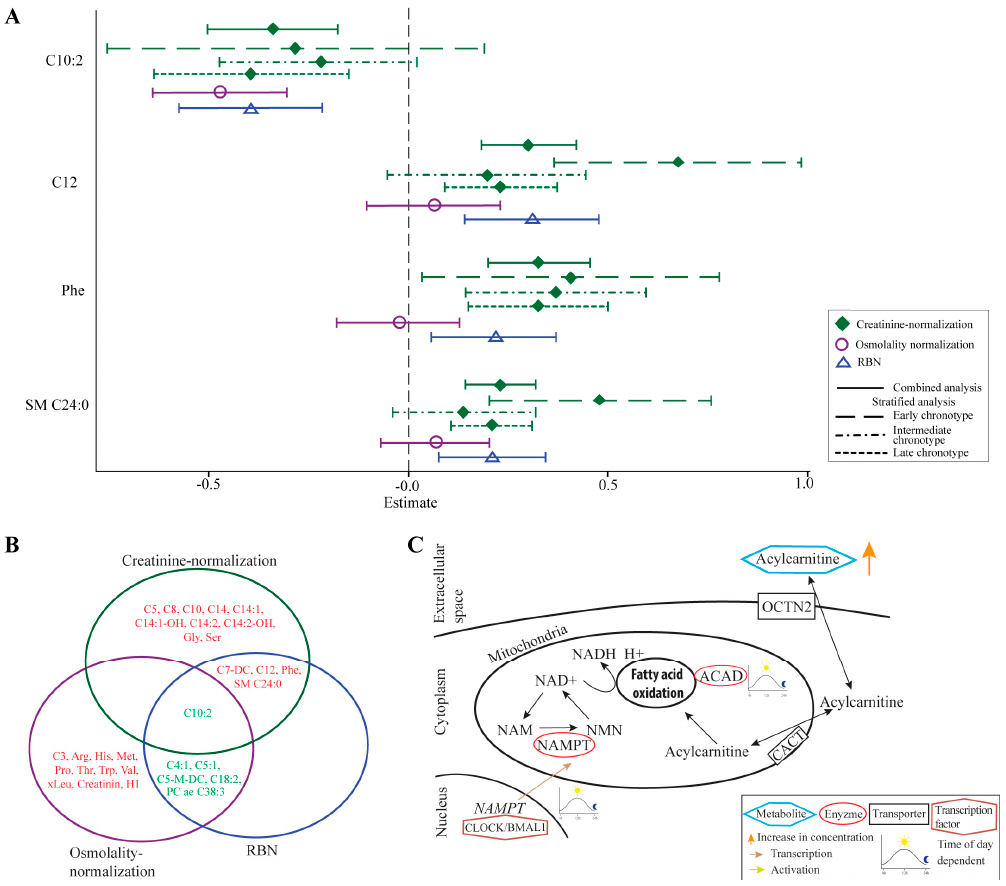
Figure 2. Results of four selected metabolites of three normalization methods of combined and chronotype-stratified analyses as well as pathways potentially affected by night shift work. Plot ( A ) shows the β -estimates and associated 95% confidence intervals of four metabolites based on creatinine-, osmolality- and regression based normalization of combined and stratified analysis; Plot ( B ) shows a Venn diagram of significantly altered metabolites when comparing DS with NS in the combined analysis of three normalization methods. Colours indicate the direction of the observed change (red = increase, green = decrease); Plot ( C ) depicts an overview for pathways potentially affected by night shift work. OCTN2, cell membrane carrier; CACT, Carnitine acylcarnitine translocase; NAD, Nicotinamide adenine dinucleotide (oxidised); NADH, Nicotinamide adenine dinucleotide (deoxidised); NAM, Nicotinamide; NMN, Nicotinamide mononucleotide; NAMPT, nicotinamide phosphoribosyl transferase; NAMPT , Gene encoding NAMPT.